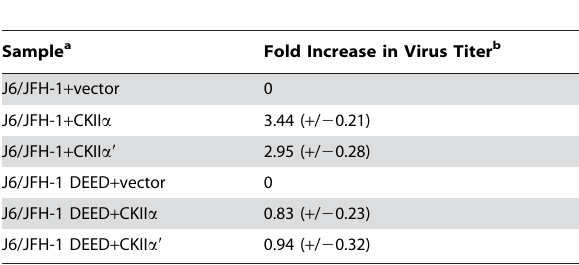
Table 2. CKII over expression increases infectious virus